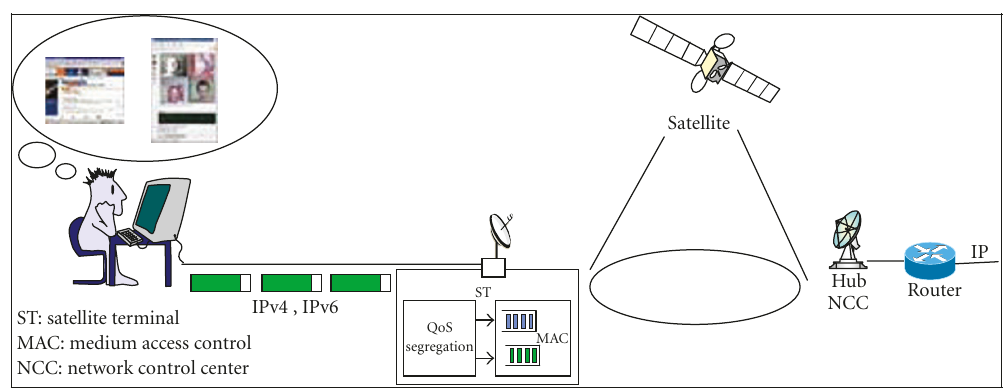
Figure 2: QoS signaling principle.